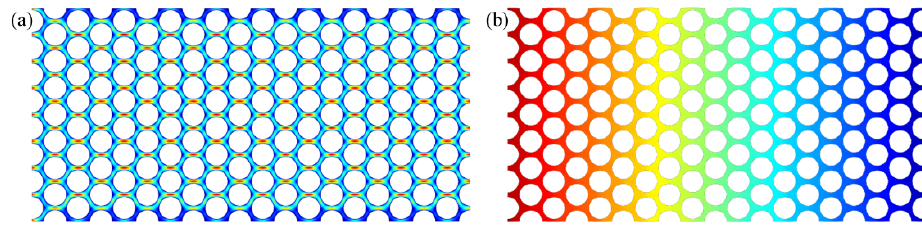
Figure 1. Schematic diagram of the pore-scale model and its boundary conditions. The obtained velocity and pressure fields are shown in Figure 2, in which the white indicates the solid particles. Since the single-phase flow simulation ignores the influence of gravity, the velocity and pressure fields are symmetrically distributed, which verifies the numerical models.